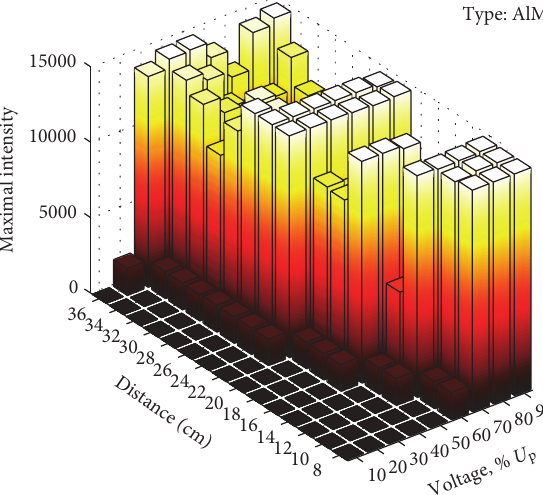
Figure 13: Dependency of voltage and distance on the number of wavelength components for the MIG308LSi line.